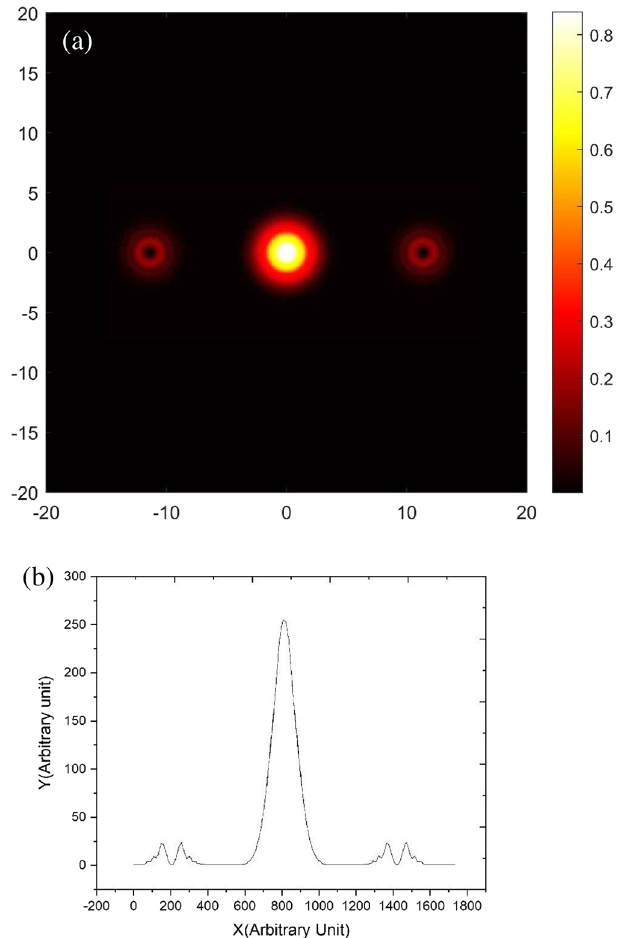
Figure 13. ( a ) The simulated image of the diffracted beam from the fork shape phase grating, ( b ) the corresponding intensity profile of the grating with 8% diffraction efficiency.